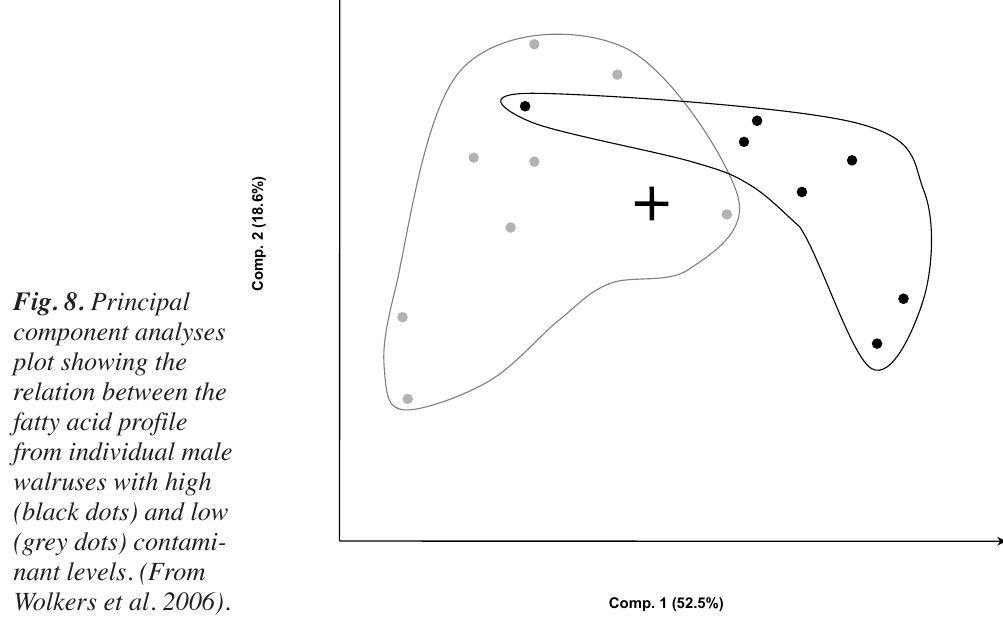
Fig. 8. Principal component analyses plot showing the relation between the fatty acid profile from individual male walruses with high (black dots) and low (grey dots) contami- nant levels. (From Wolkers et al.